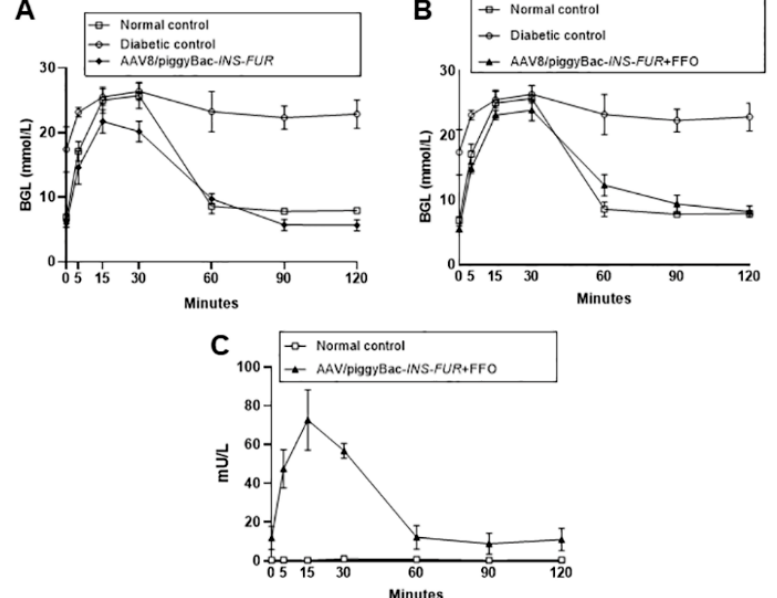
Figure 5. Normalisatiion of glucose tolerance of diabetic NOD mice after expression of INS-FUR by the integrating piggyBac / AAV8 vector combined with the FFO surgical procedure. Diabetic NOD mice were transduced with INS-FUR , or INS-FUR in combination with the FFO surgical procedure at 7 days after transduction, using the integrating piggyBac / AAV8. ( A ) Blood glucose levels following an IPGTT of diabetic (n = 3), non-diabetic (n = 7) and diabetic NOD mice that received i.p. injections of INS-FUR alone as AAV8- piggyBac / INS-FUR -mCherry (n = 7). ( B ) Blood glucose levels following an IPGTT of diabetic (n = 3), non-diabetic (n = 7) and diabetic NOD mice that received i.p. injections